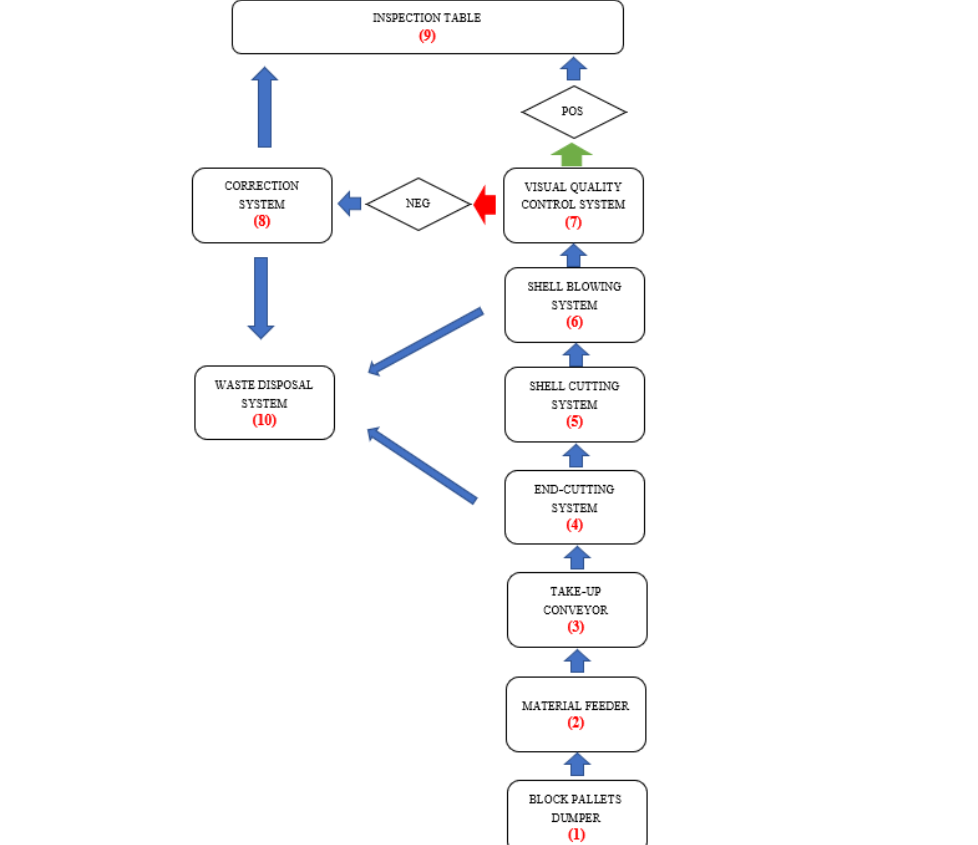
Figure 3. Modular and functional diagram of the test stand construction: POS—positive result, NEG—negative result, (1)—block pallets dumper, (2)—material feeder, (3)—take-up conveyor, (4)—end-cutting system, (5)—shell cutting system, (6)—shell-blowing system, (7)—visual quality control system, (8)—correction system, (9)—inspection table, and (10)—waste disposal system. The onions should be positioned in the carriers with the correct spatial orientation.